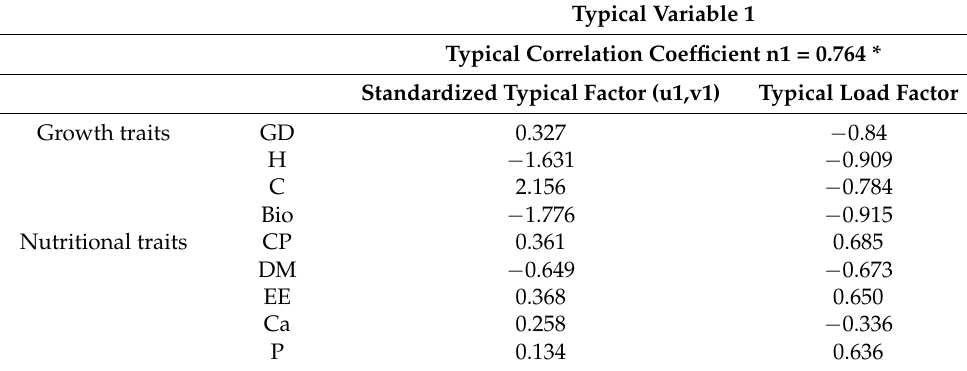
Table 5. Canonical correlation analysis of growth and nutritional